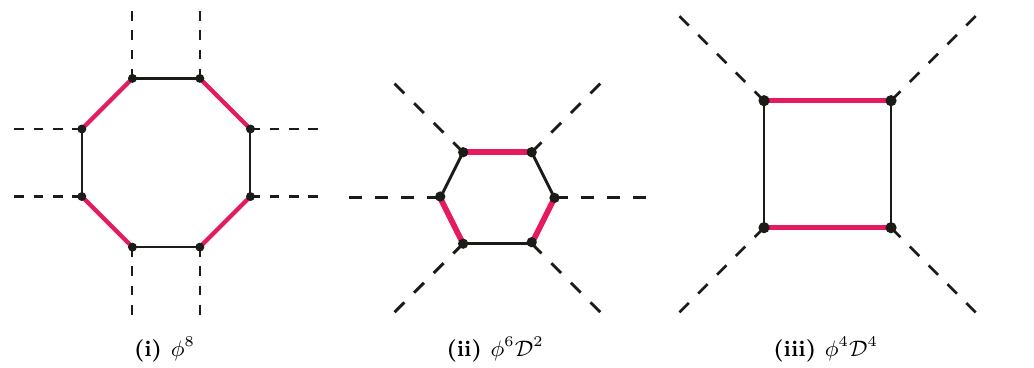
Figure 5. Schematic diagrams revealing light-heavy fermion mixing incorporated within (i) φ 8 , (ii) φ 6 D 2 , and (iii) φ 4 D 4 classes of SMEFT